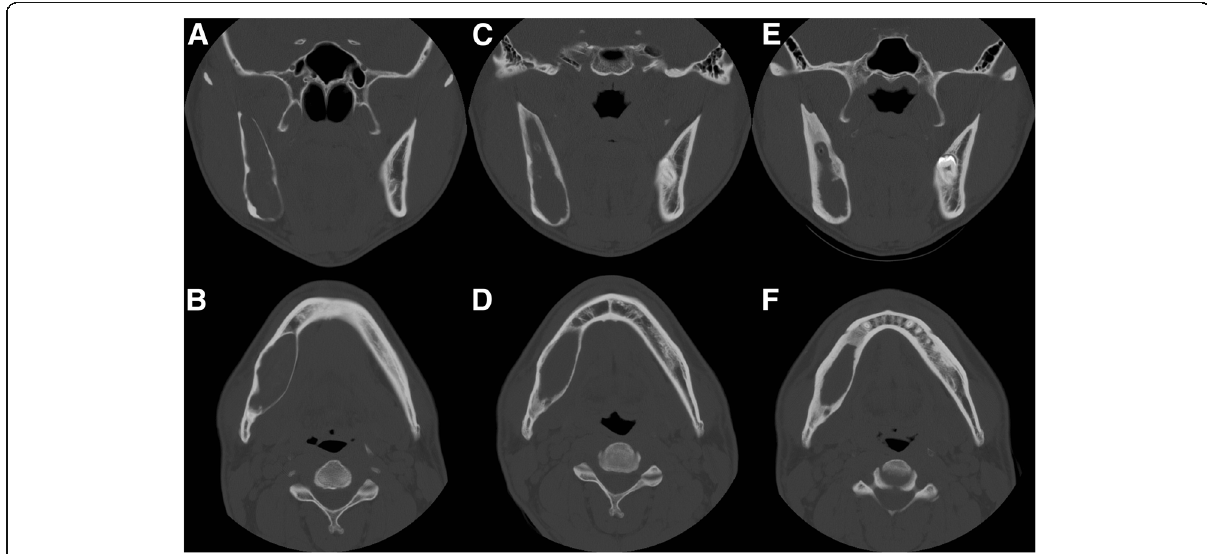
Fig. 1 Representive serial axial and coronal CT of OKC decompression. During the decompression for about 18 months, remarkable reduction in lesion size and increased cortical bone thickness with new bone formation is observed. ( a , b initial, c , d 6 months decompression, e ,